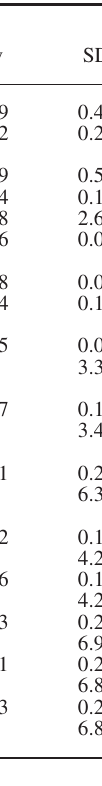
T ABLE 3. – Summary Summary of some morphological characters of Geminosyllis granulosa sp. nov. and Geminosyllis sp. 1 from Spanish seas. *: palps plus prostomium plus 10 fist segments. N: number of organisms; Min: Minimum; Max: maximum; Av: average; SD: standard deviation; DT: dorsal tentacular. Measurements in